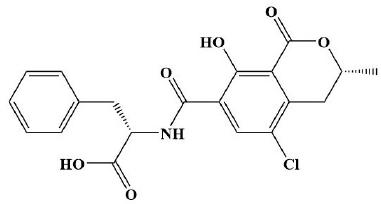
Figure 1. Chemical structure of target analyte (Ochratoxin-A, OTA) of this